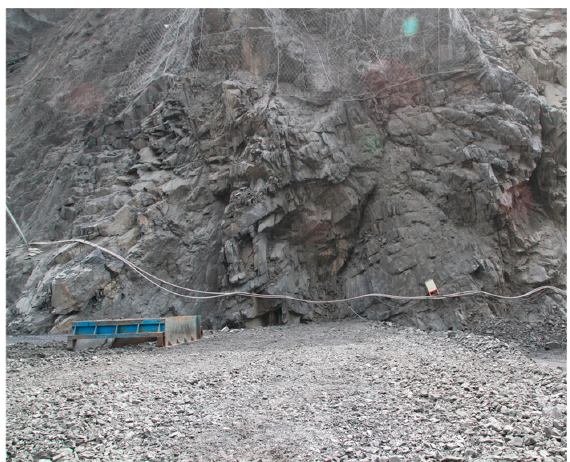
Figure 1. Slope rock mass of the left bank near the dam site of the Lianghekou Hydropower Station.